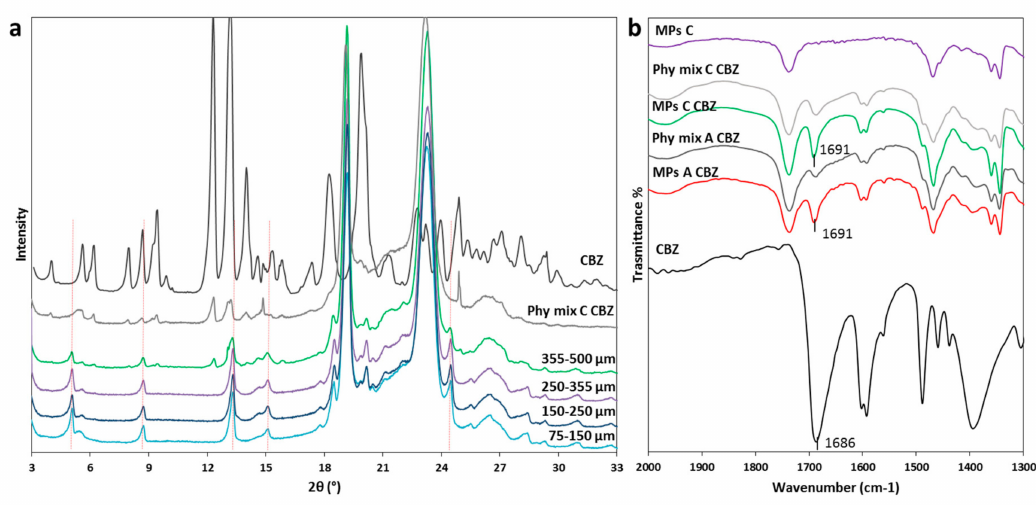
Figure 5. ( a ) XRPD spectra of di ff erent size fractions of MPs C CBZ compared to CBZ and Phy mix C CBZ; ( b ) FT-IR spectra of CBZ, MPs A CBZ, Phy mix A CBZ, MPs C CBZ, Phy mix C CBZ and